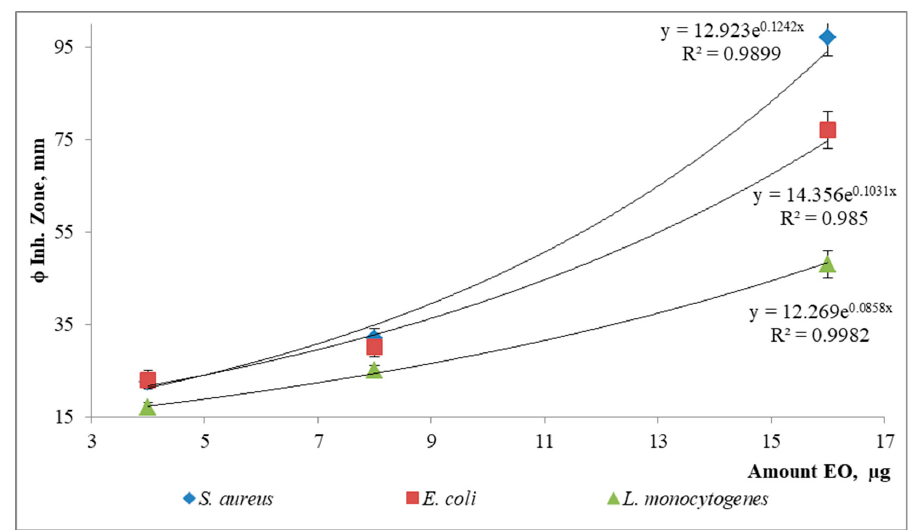
Figure 1. Effect of the EO amount on the inhibition of bacterial growth.